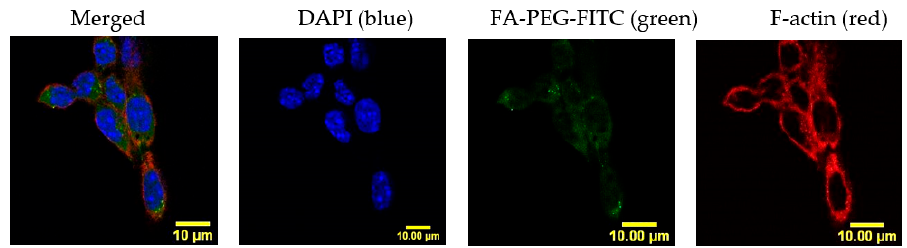
Figure 2. Folic acid distributes in the LLC cell cytosol after uptake. Confocal imaging of LLC cells labeled with cytoskeletal F-actin (red) and nucleus (DAPI, blue) confirm subcellular localization of FA-PEG-FITC (green) throughout the cytosol after 1 h of incubation. Scale bar: 10 μ m.